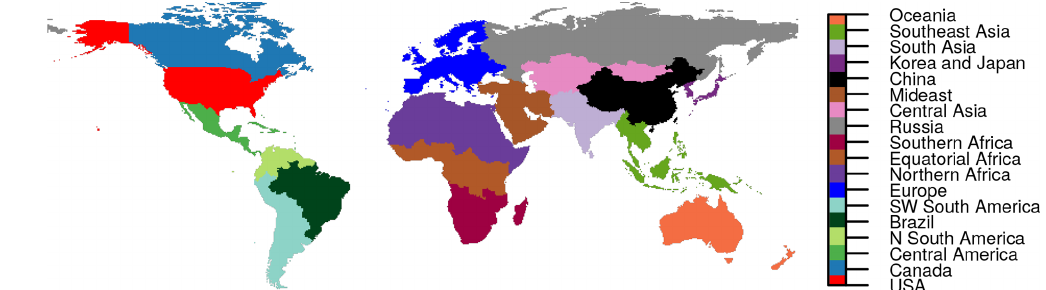
Figure A2. REgional Carbon Cycle Assessment and Processes’, Phase 2 (RECCAP2) regions as defined in Tian et al. (2019).